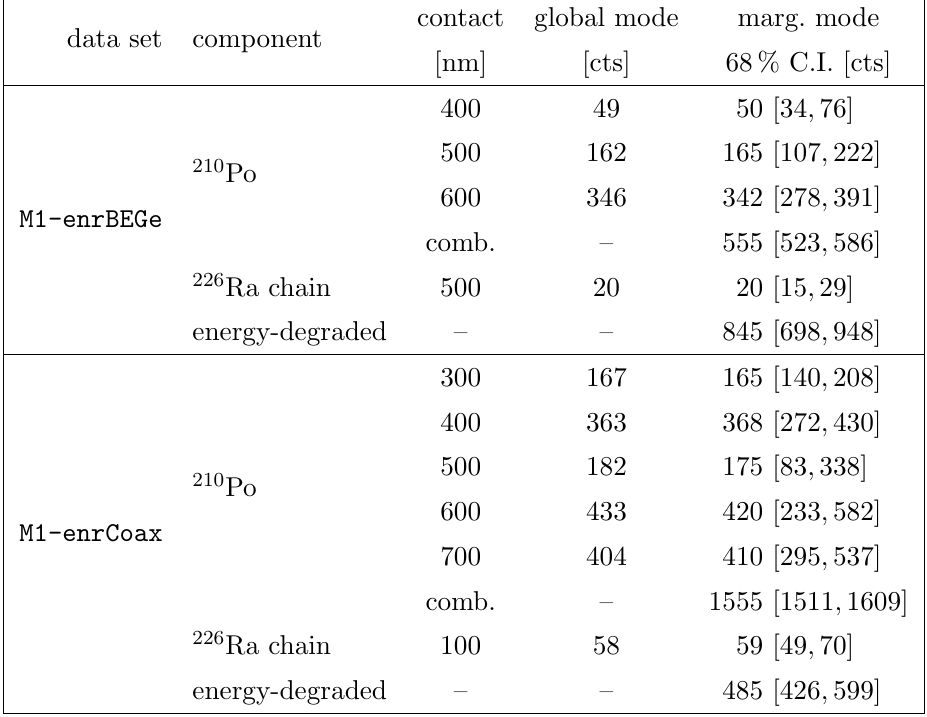
Table 8. Fit results of the (cid:11) events background analysis for the M1-enrBEGe and M1-enrCoax data sets. Values are given in counts in the full PDF range from 40 keV to 8000